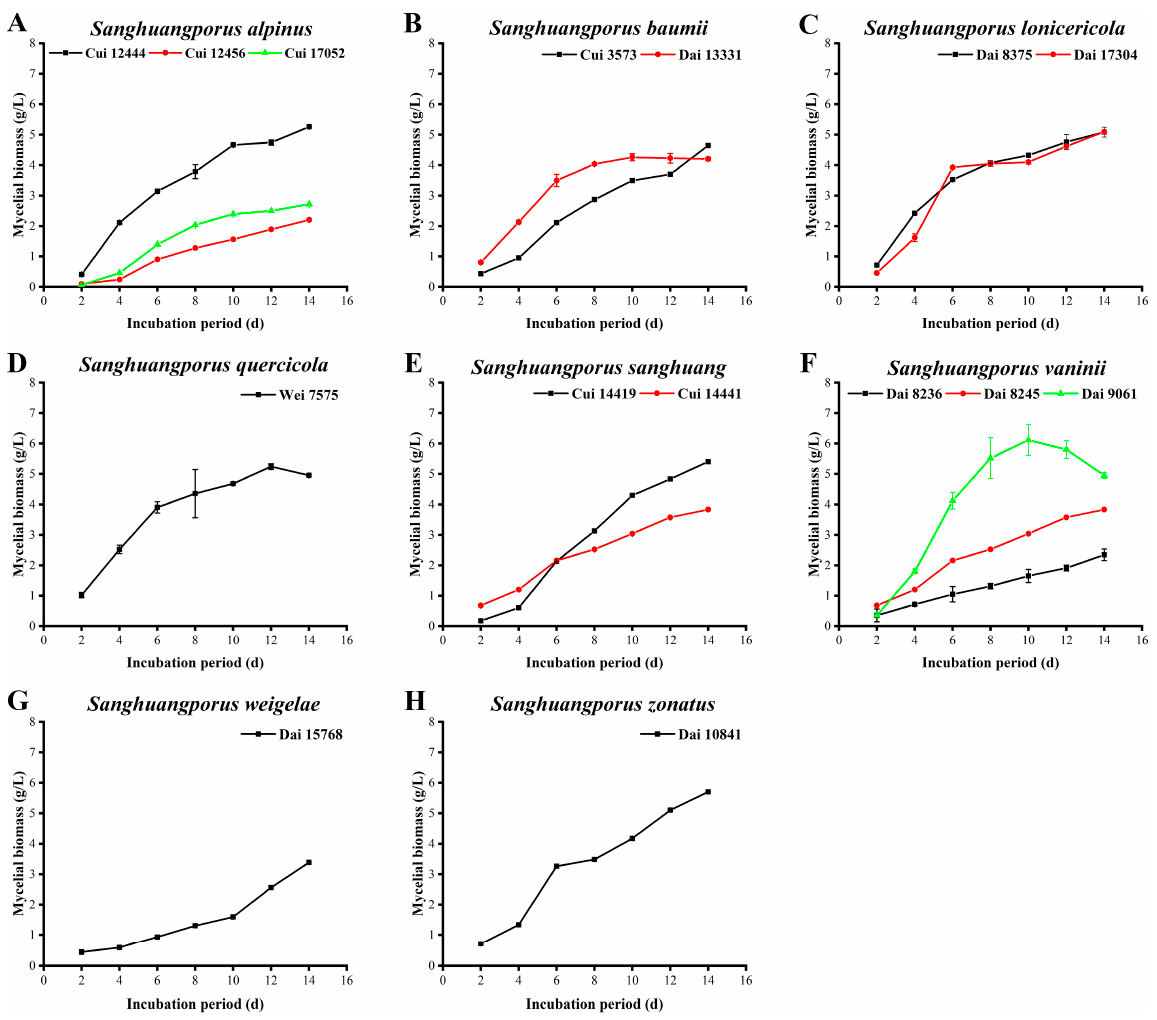
Figure 1. Variations in mycelial biomass during submerged fermentation of 15 wild strains from